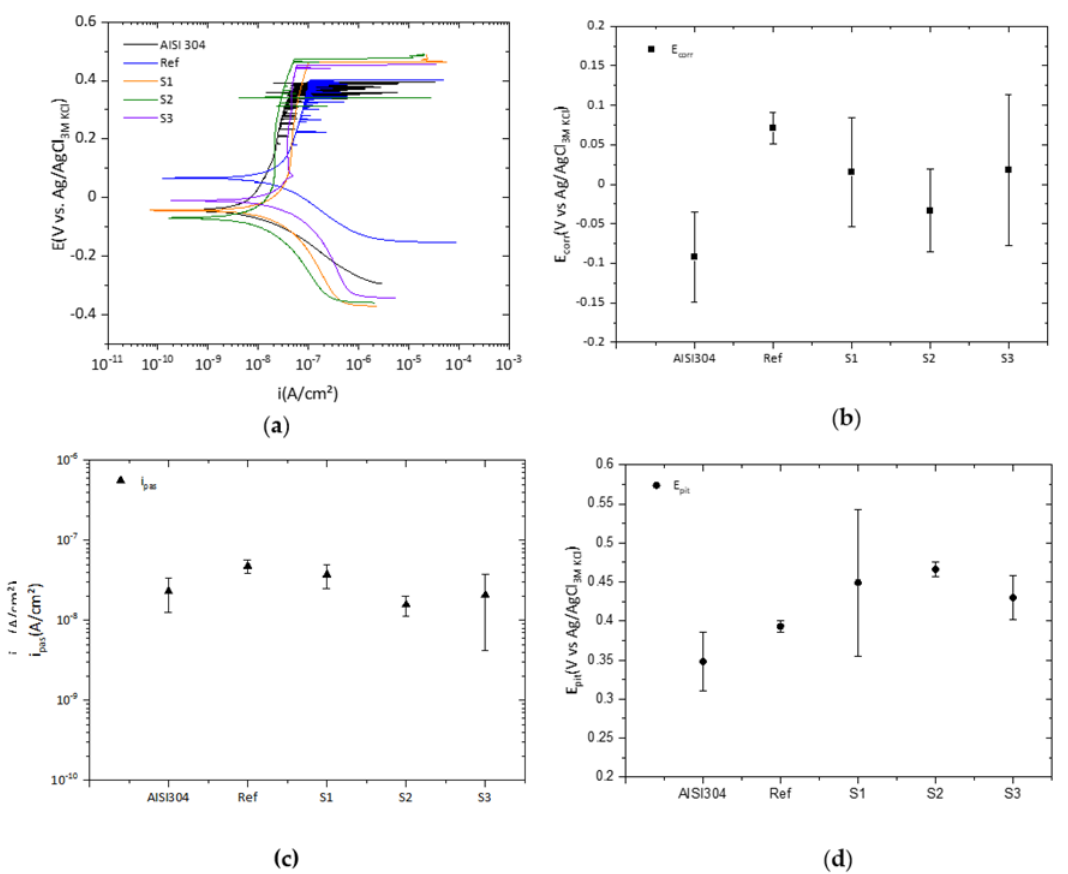
Figure 12. ( a ) Comparison of the representative potentiodynamic curves for the coated samples and AISI 304, and the average values of the main electrochemical parameters; ( b ) corrosion potential, E corr ; ( c ) passive current density, i pass ; ( d ) pitting potential, E pit .